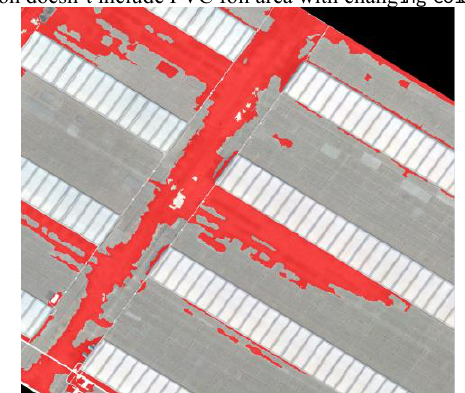
Figure 6 . Automatic roof leak detection